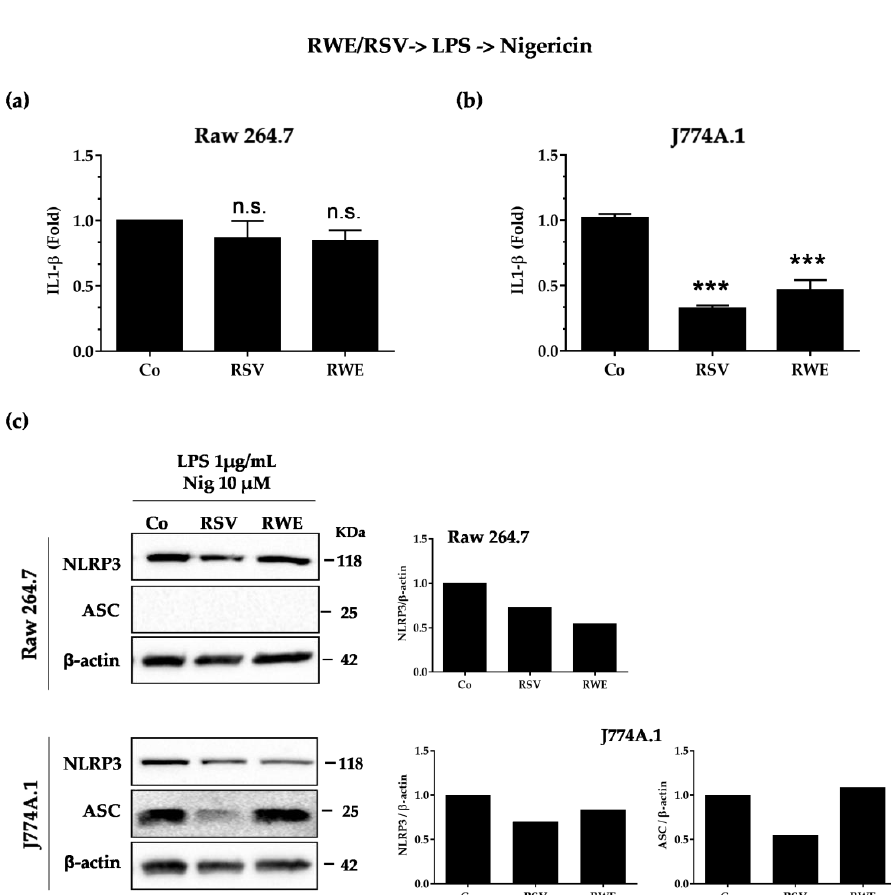
Figure 3. RWE and RSV curtail NLRP3 inflammasome priming and reduce IL-1 β secretion, in the nigericin-mediated activation condition. Raw 264.7 ( a ) and J774A.1 ( b ) macrophages were pretreated or not with RWE (100 µ g/mL) or RSV (60 µ M) for 30 min, prior to NLRP3 inflammasome priming with 1 µ g/mL of LPS for 5.5 h and subsequent activation by 10 µ M nigericin for 30 min. Secreted IL-1 β in cell supernatants was analyzed by ELISA at the end of the treatments. Data are expressed as fold changes in secreted IL-1 β levels as compared to cells treated with only LPS + nigericin (Co) and are mean ± s.d. of three independent experiments. p -values were determined by the multiple Student t test. n.s.: not significant, *** p < 0.001. ( c ) Western-blot analysis of NLRP3 and ASC protein expression in Raw 264.7 and J774A.1 macrophages after cell treatments as described above. Left panels: representative blots from three independent experiments are shown. β -actin was used as loading control. Right panels: densitometry quantifications of representative blots. Plotted data are fold changes as compared to LPS-treated cells